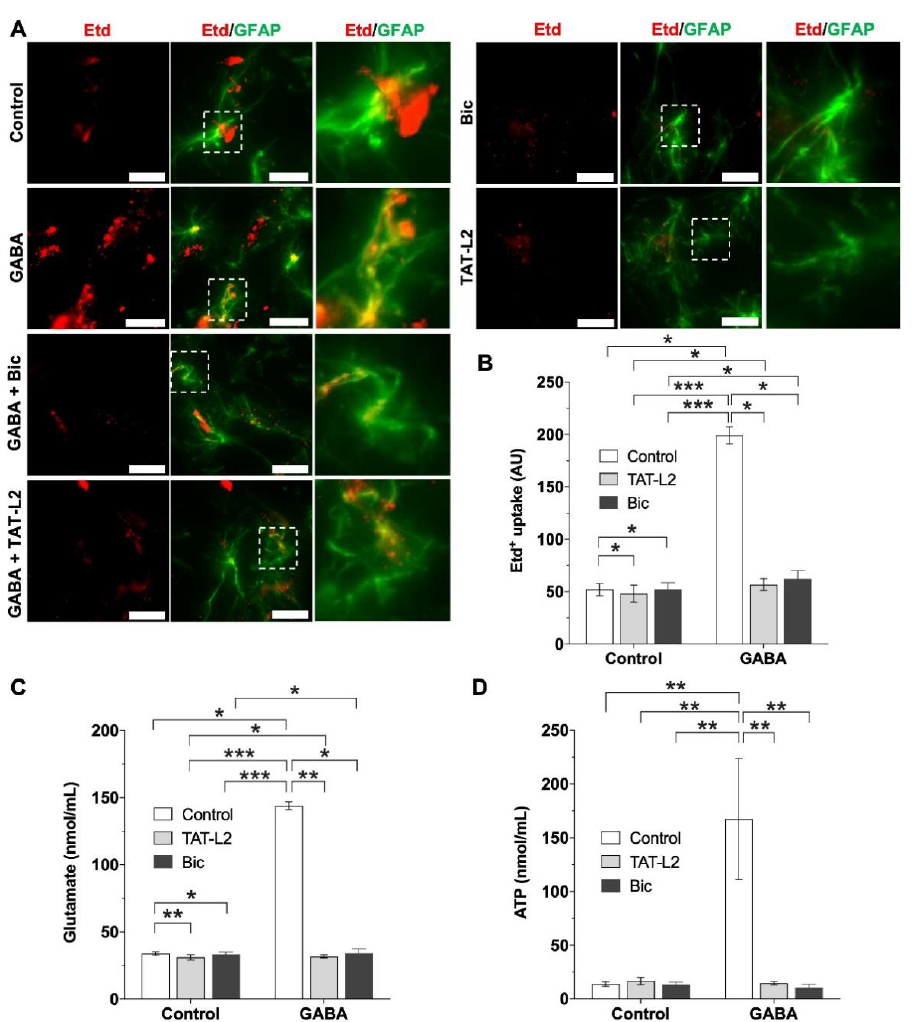
Figure 5. GABA increases astroglial Cx43 hemichannel activity in rat hippocampal slices via activation of GABA A receptors. ( A ) Representative photomicrographs showing ethidium (Etd + ) uptake (red) and GFAP immunolabeling (green) in hippocampal slices. Scale bar: 50 µ m. ( B ) Quantification of Etd + uptake. Increased Etd + uptake was found in response to 1 µ M GABA (GABA), an effect that was prevented by preincubation with 100 µ M bicuculline (Bic) or 10 nM TAT-Cx43L2 (TAT-L2). ( C ) Extracellular glutamate concentration from the culture medium of hippocampal slices without ligands (control), or after incubation with 1 µ M GABA alone (GABA), or after preincubation with 100 µ M bicuculline (Bic) or 10 nM TAT-Cx43L2 (TAT-L2). ( D ) Extracellular ATP concentration without ligand (control) or after incubation with 1 µ M GABA alone (GABA) or preincubated with 100 µ M bicuculline (Bic) or 10 nM TAT-Cx43L2 (TAT-L2). In all cases, n = 3, with technical triplicates. Error bars: SE; * p < 0.05, ** p < 0.01 and *** p <